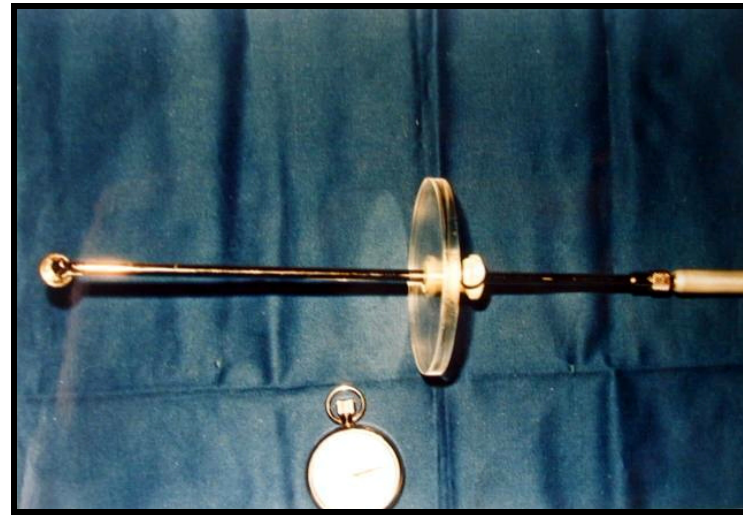
FIGURE 5 - Photograph showing the Strontium-90 plate used for the emission of beta radiation on the end of a protection rod and the chronometer used.